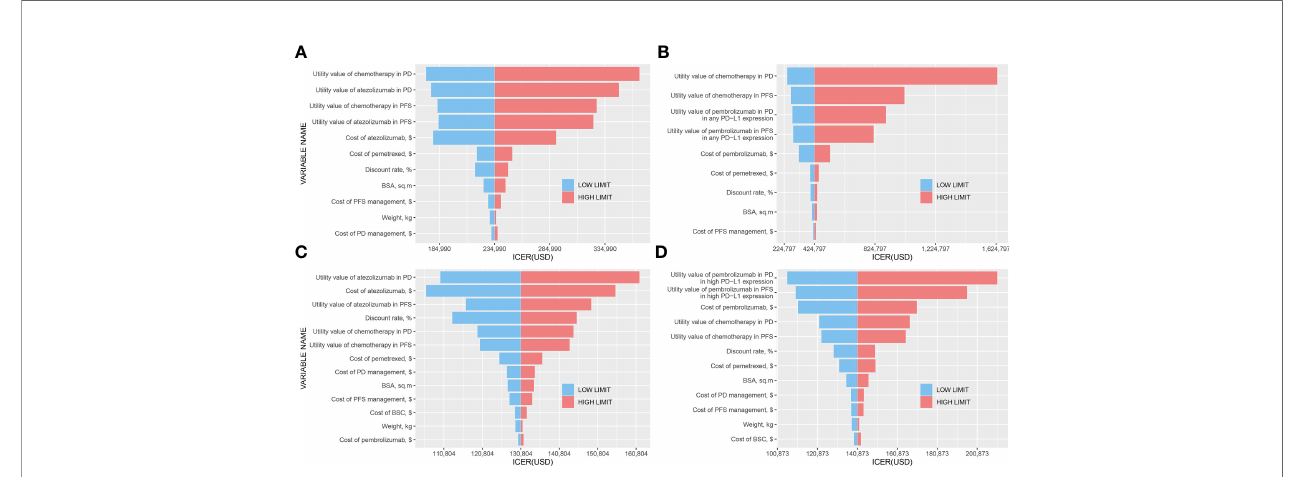
FIGURE 2 | Tornado diagrams. (A) Atezolizumab vs. Chemotherapy in any PD-L1 expression population; (B) Pembrolizumab vs. Chemotherapy in any PD-L1 expression population; (C) Atezolizumab vs. Chemotherapy in high PD-L1 expression population; (D) Pembrolizumab vs. Chemotherapy in high PD-L1 expression population.